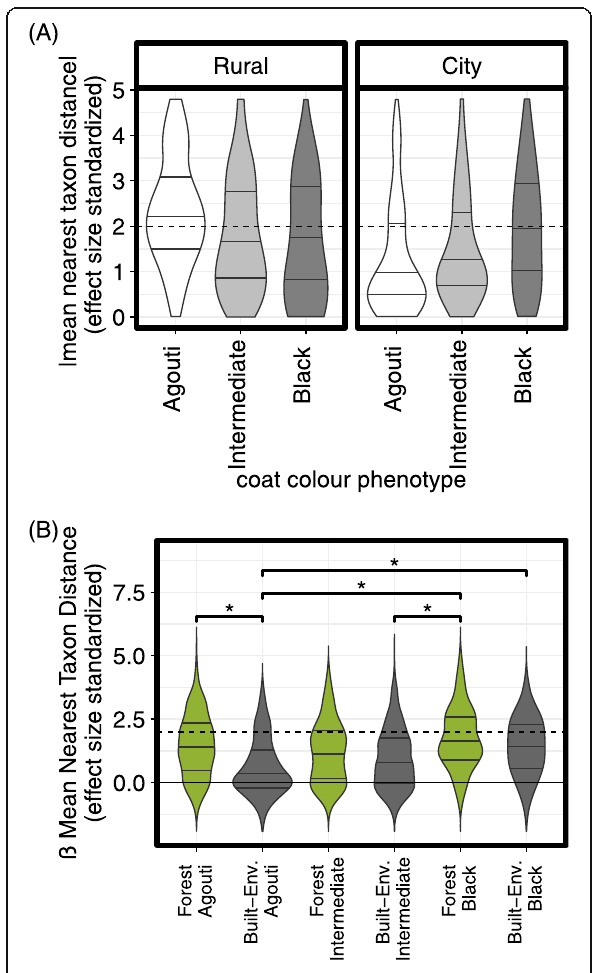
Fig. 5 An interaction between coat colour phenotype and environment affected ( A ) |mean nearest taxon distances| (box-cox transformed) (city versus rural), and ( B ) β mean nearest taxon distance ( β MNTD ses ) (built-environment versus forest), such that city and built-environment agouti squirrels had values closer to stochastic expectations. Dotted horizontal lines denote values beyond two standard deviations from the null distribution. Solid horizontal lines within violins denote the interquartile range. Horizontal brackets and ‘ * ’ denote significant differences in β MNTD ses variance homogeneity using permutation tests ( p <